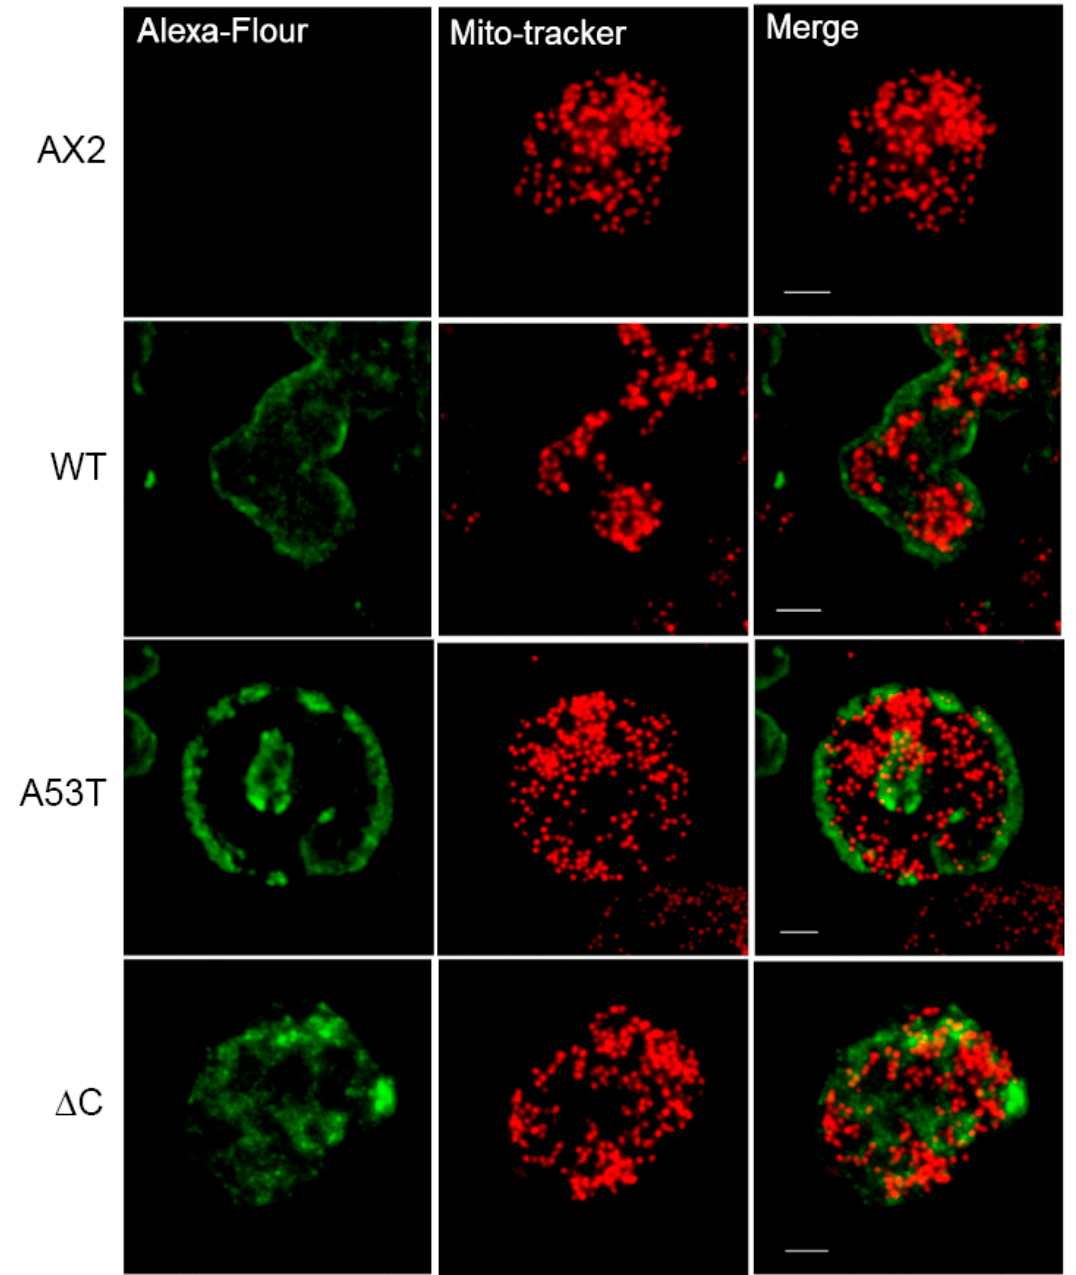
Figure A1. α -synuclein does not colocalise with mitochondria.